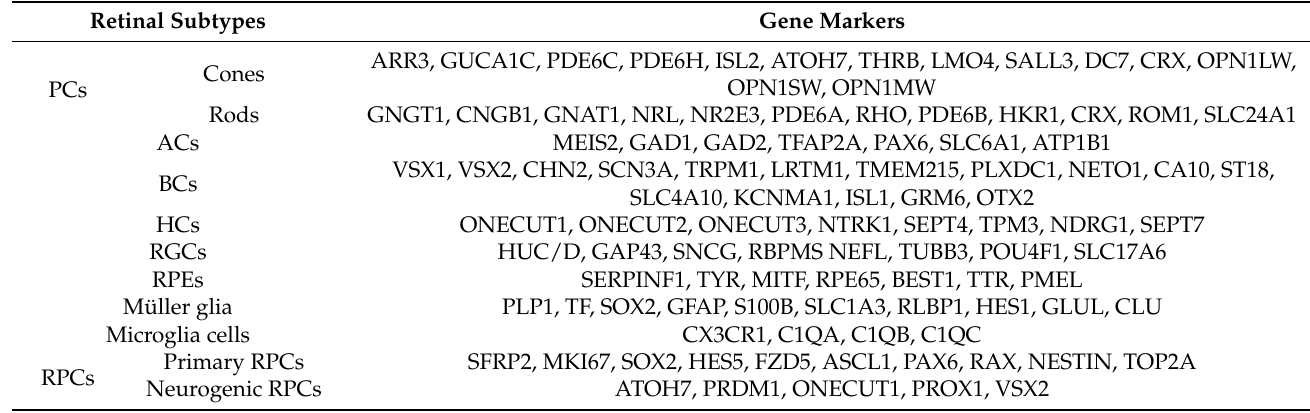
Table 2. Common gene markers of main retinal cells in